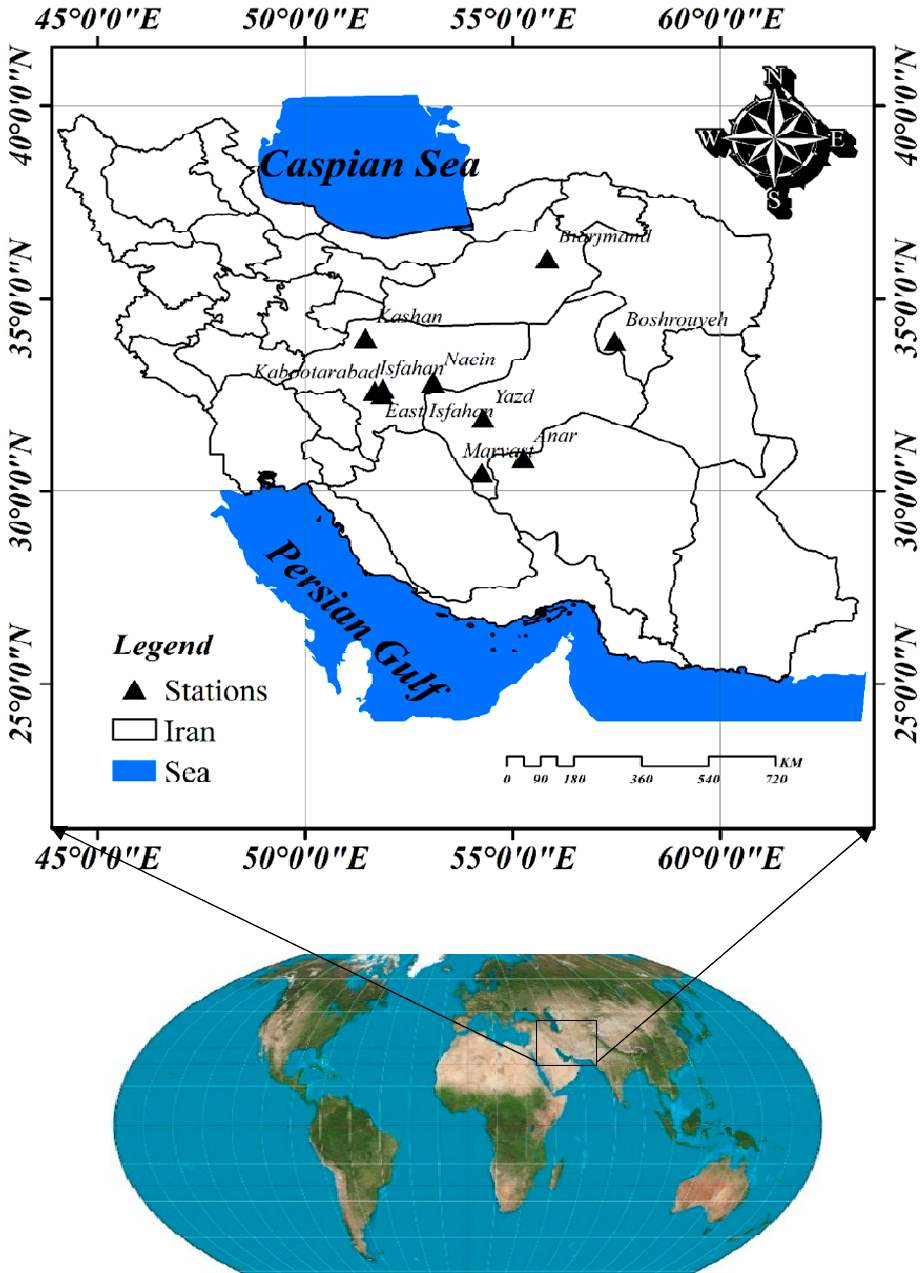
Figure 1. Situation of the intended stations in Iran.